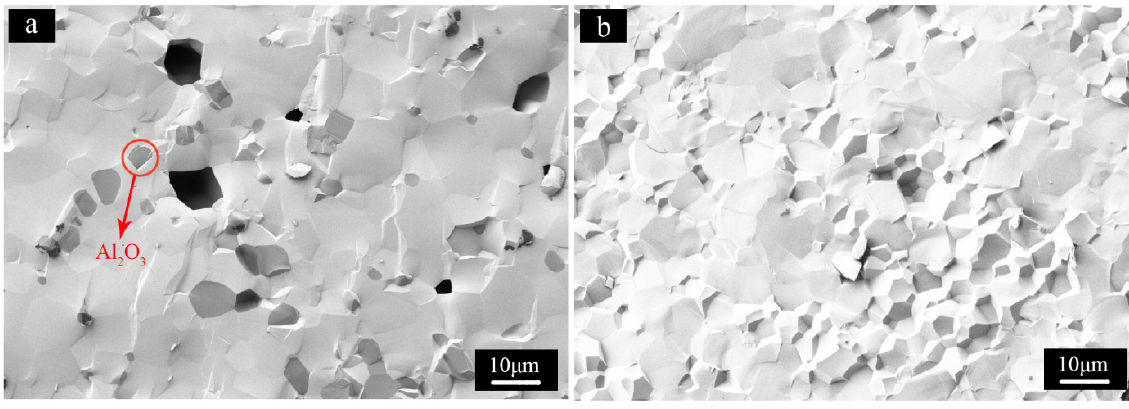
Figure 8. SEM micrographs of the fractured surfaces of ceramics of S3 ( a ) and S7 ( b ).